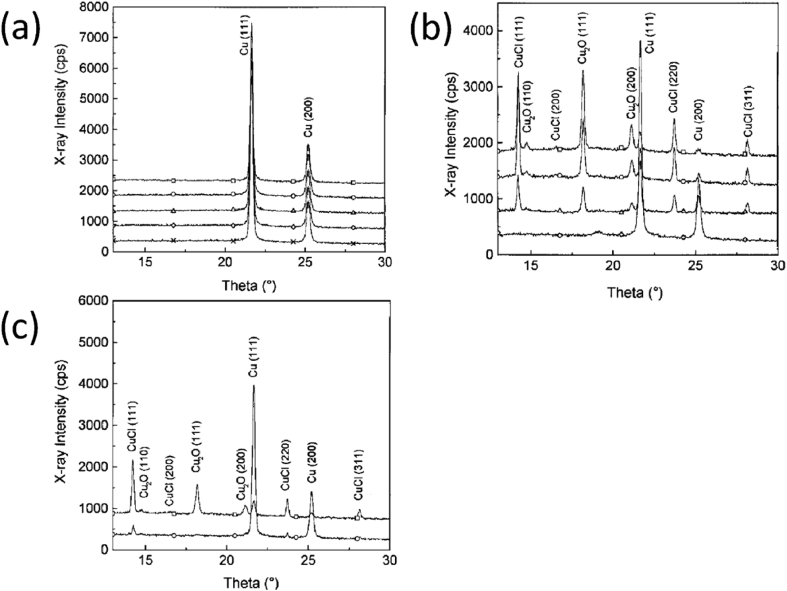
Glancing incidence XRD spectra obtained from copper in 0.1 N NaCl as a function of immersion time for: (a) 0 mV vs SCE; (b) 100 mV vs SCE; (c) 200 mV vs SCE. From Sathiyanarayanan et al. [1999].36